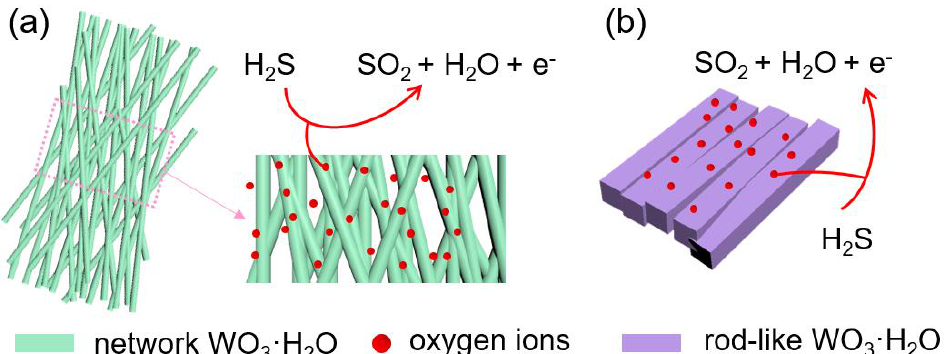
Figure7. Gas sensing mechanism of the ( a ) network WO 3 ·H 2 O and ( b ) rod − like WO 3 ·H 2